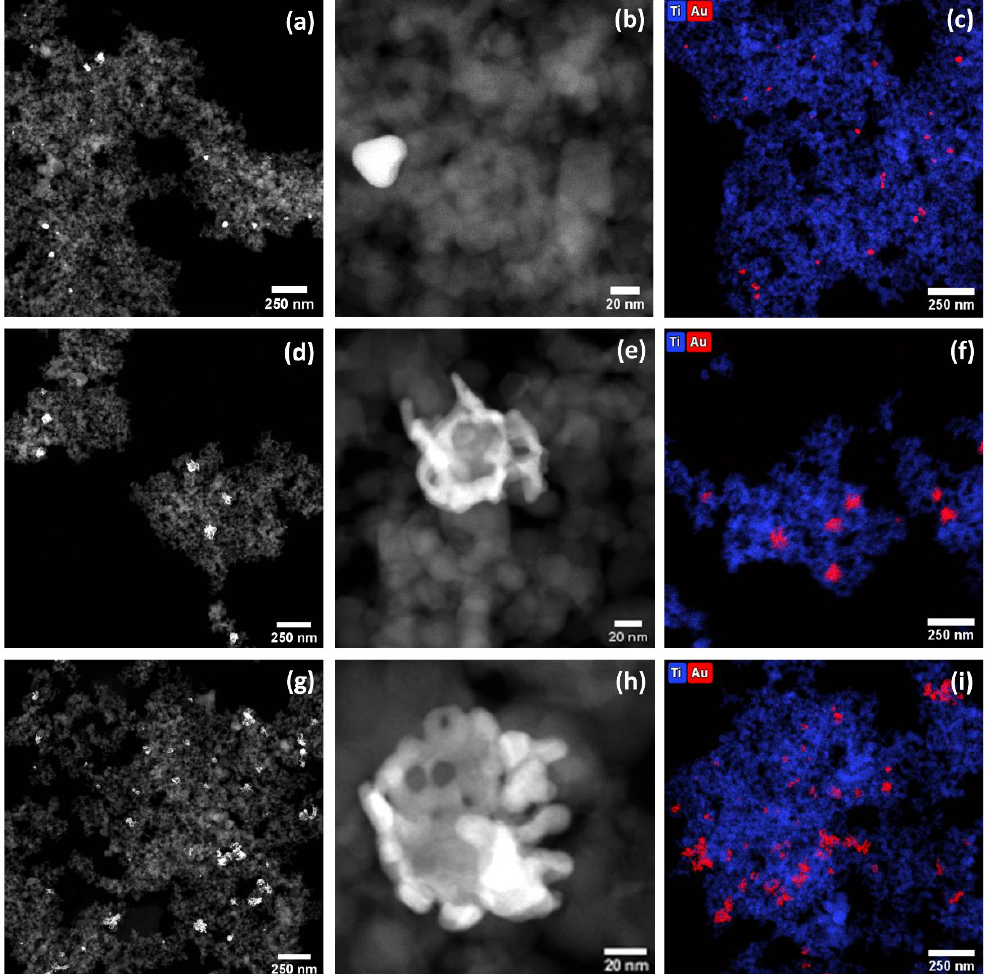
Figure 1. STEM-HAADF micrographs with the different magnifications ( a , b , d , e , g , h ) and EDX map- ping ( c , f , i ) of TiO 2 :Au-NSs, Sample A ( a – c ), Sample B ( d – f ), and Sample C ( g – i ).